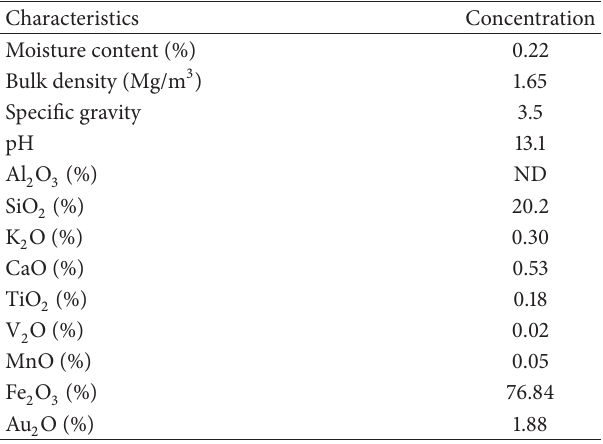
Table 4: Physical and chemical characteristics of iron ore tailings.